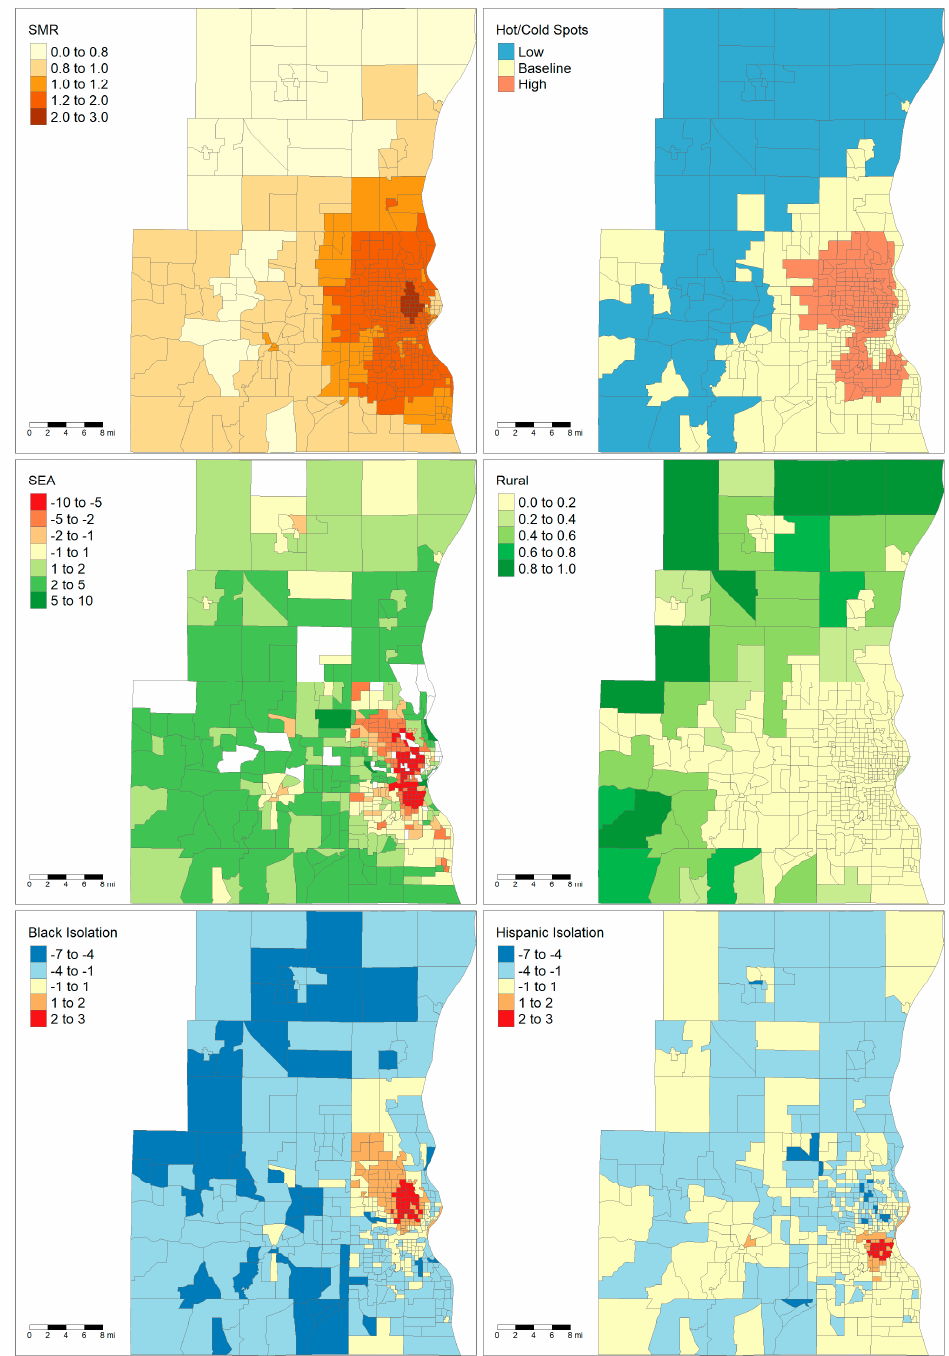
Figure 2. Maps of Milwaukee–West Allis–Wauwatosa, WI MSA. Upper left: liver cancer SMRs. Upper right: high- and low-mortality clusters of liver cancer. Middle left: socioeconomic advantage index with white tracts indicating areas whose ACS errors were outliers. Middle right: rurality. Lower left: Black local isolation scores. Lower right: Hispanic local isolation scores. Abbreviations: WI: Wisconsin, SMR: Standardized Mortality Rate, ACS: American Community Survey.